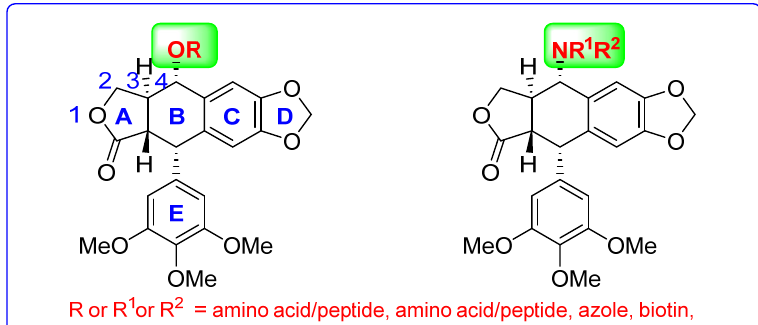
Figure 1. Podophyllotoxin and podophyllotoxin derivatives.